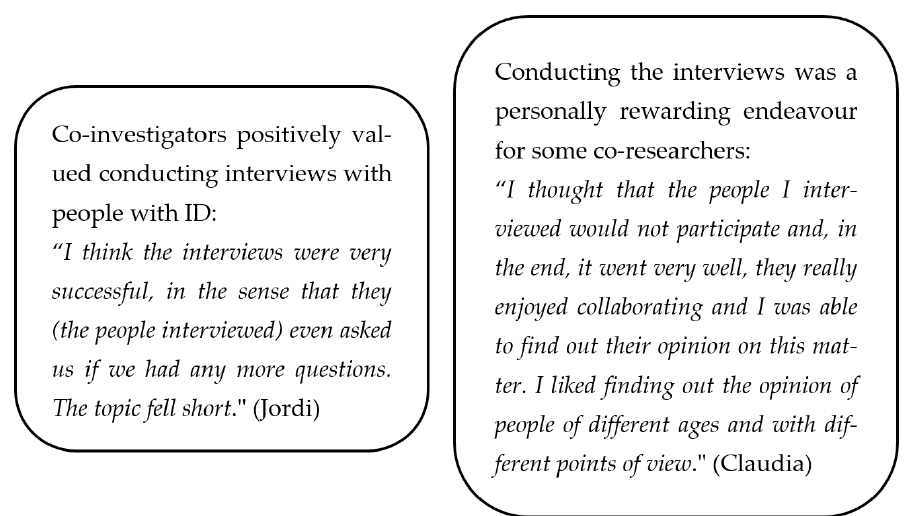
Figure 3. Co-researchers’ opinions 6, 7.